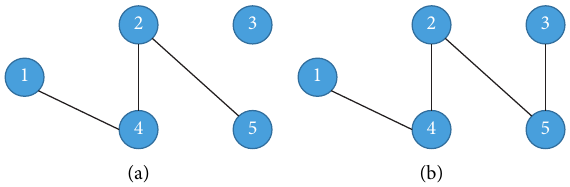
Figure 2: Example of domination. Line (a) is dominated by line